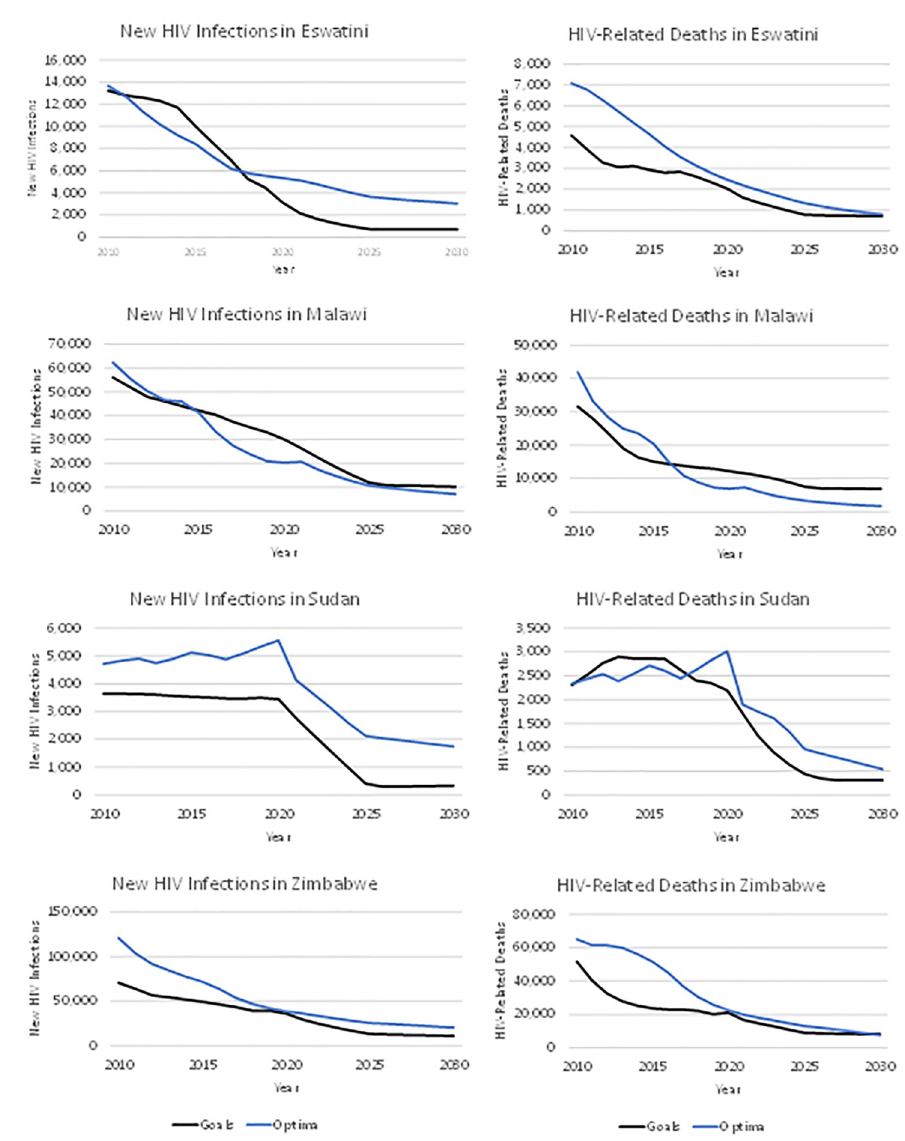
Fig 5. Comparison of Optima HIV and goals